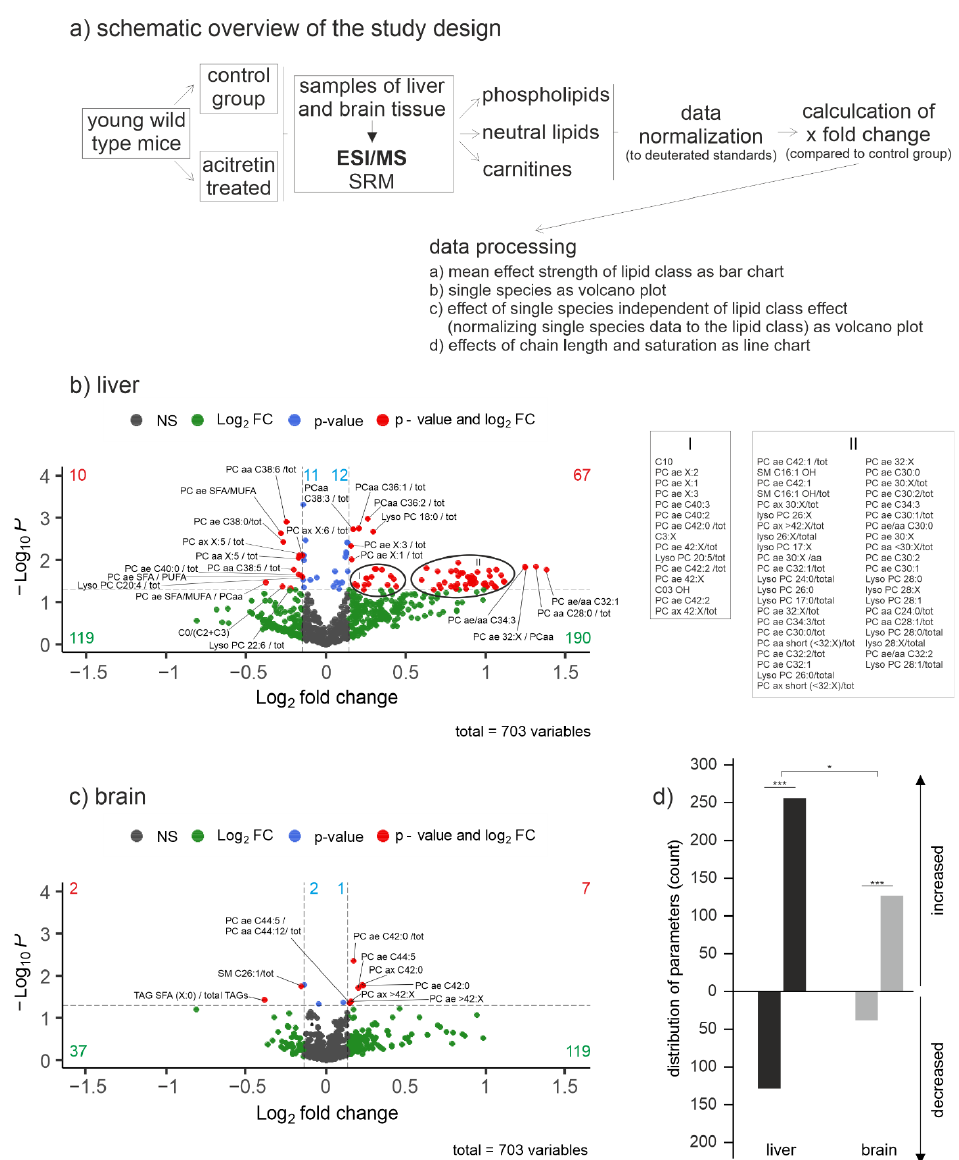
Figure 1. Lipid changes in acitretin-treated wild type mice compared to controls. Mice were treated starting from the age of 9 weeks with seven daily acitretin i.p. injections. One liver lobe and one hemisphere of the brain were harvested for lipid extraction and analysis. A schematic overview on the study design and data processing is shown ( a ). Fold changes of the included parameters are plotted logarithmically against the p -value ( − Log10) for liver ( b ) and brain tissue ( c ) of female C57Bl6/J OlaHsd mice (n = 6 per group). Lipid species without significant changes are represented as grey dots, species with a fold change greater than the average SEM as green dots. Species with a significant fold change ( p < 0.05) are indicated in blue and those with a p -value < 0.05 and a fold change greater than the SEM as red dots in the volcano plot. The exact number of changed parame- ters in every part of the volcano plot is provided in the appropriate color. For reasons of clarity and comprehensibility, names of lipid species from high density regions of lipids in liver have been in- dicated in the text besides the graph (I, II). Parameters that were significantly changed after adjust- ment of p -value to multiple testing are provided in Supplementary Figure S1. Distribution of pa-